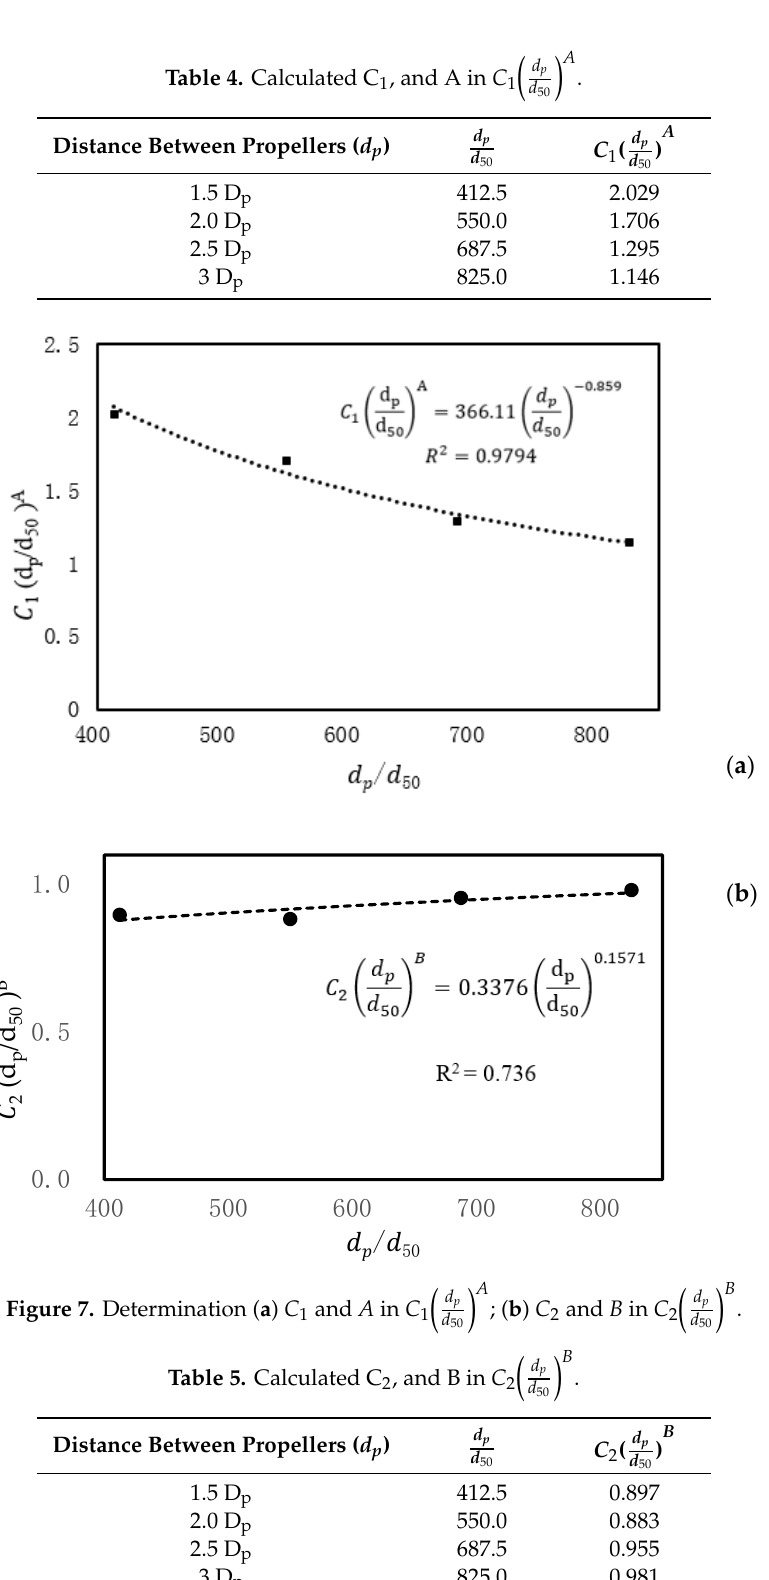
Table 5. Calculated C 2 , and B in 𝐶 (cid:2870) (cid:4672)